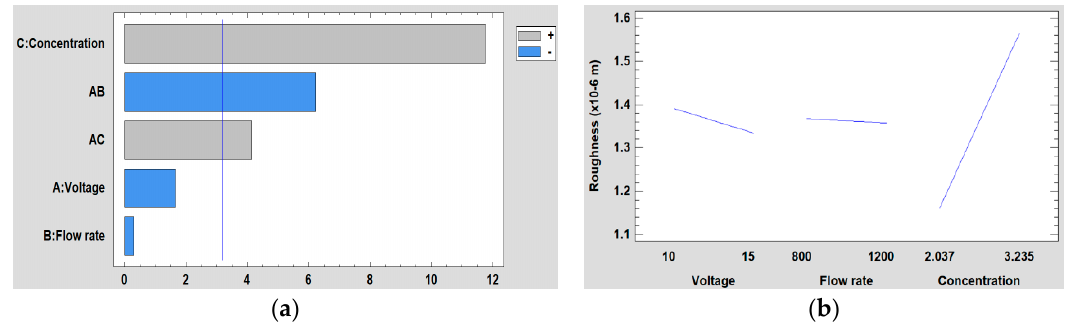
Figure 11. ( a ) Pareto chart and ( b ) the main effects on the surface roughness. The R 2 adjusted statistic obtained in the fitting of the model is 99.64% and the equation of the complete model is depicted in Equation (2).